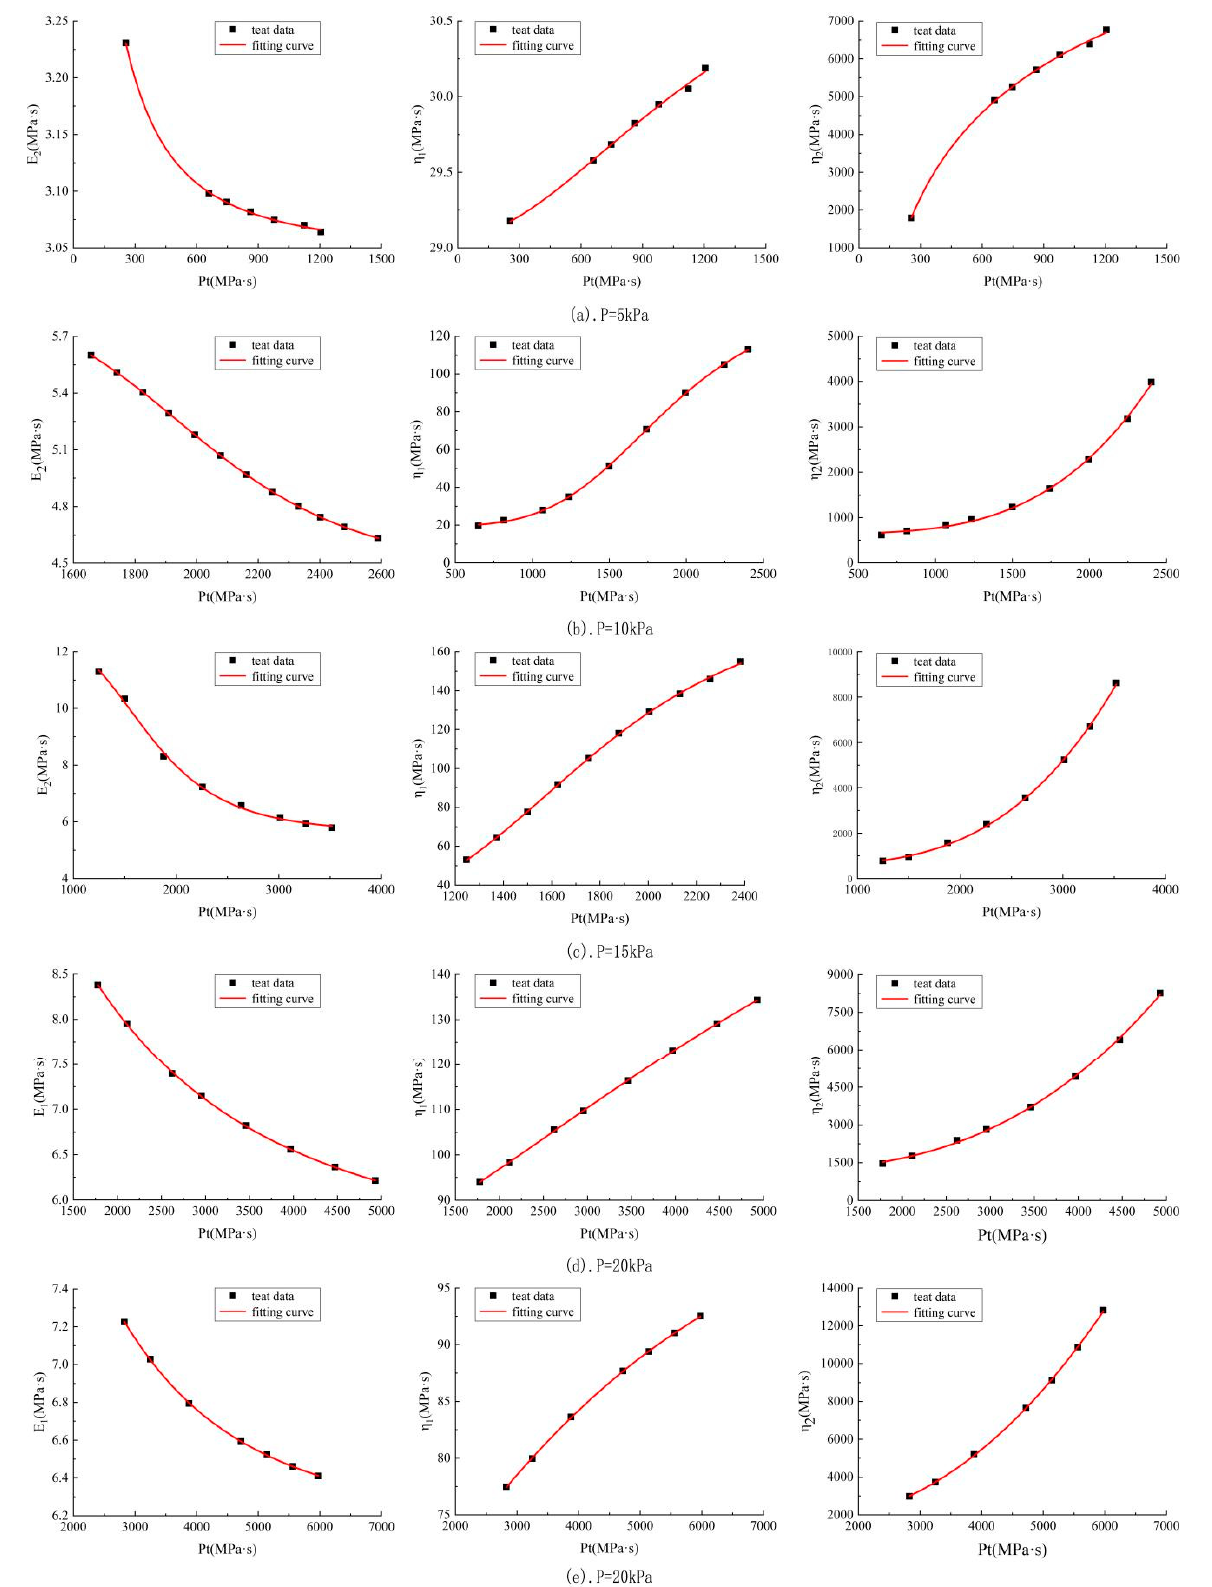
Figure 15. The variation in the pressure–sinkage parameters E 2 (left-hand column), η 1 (middle column), and η 2 (right-hand column) with the product of pressure and time ( Pt ).